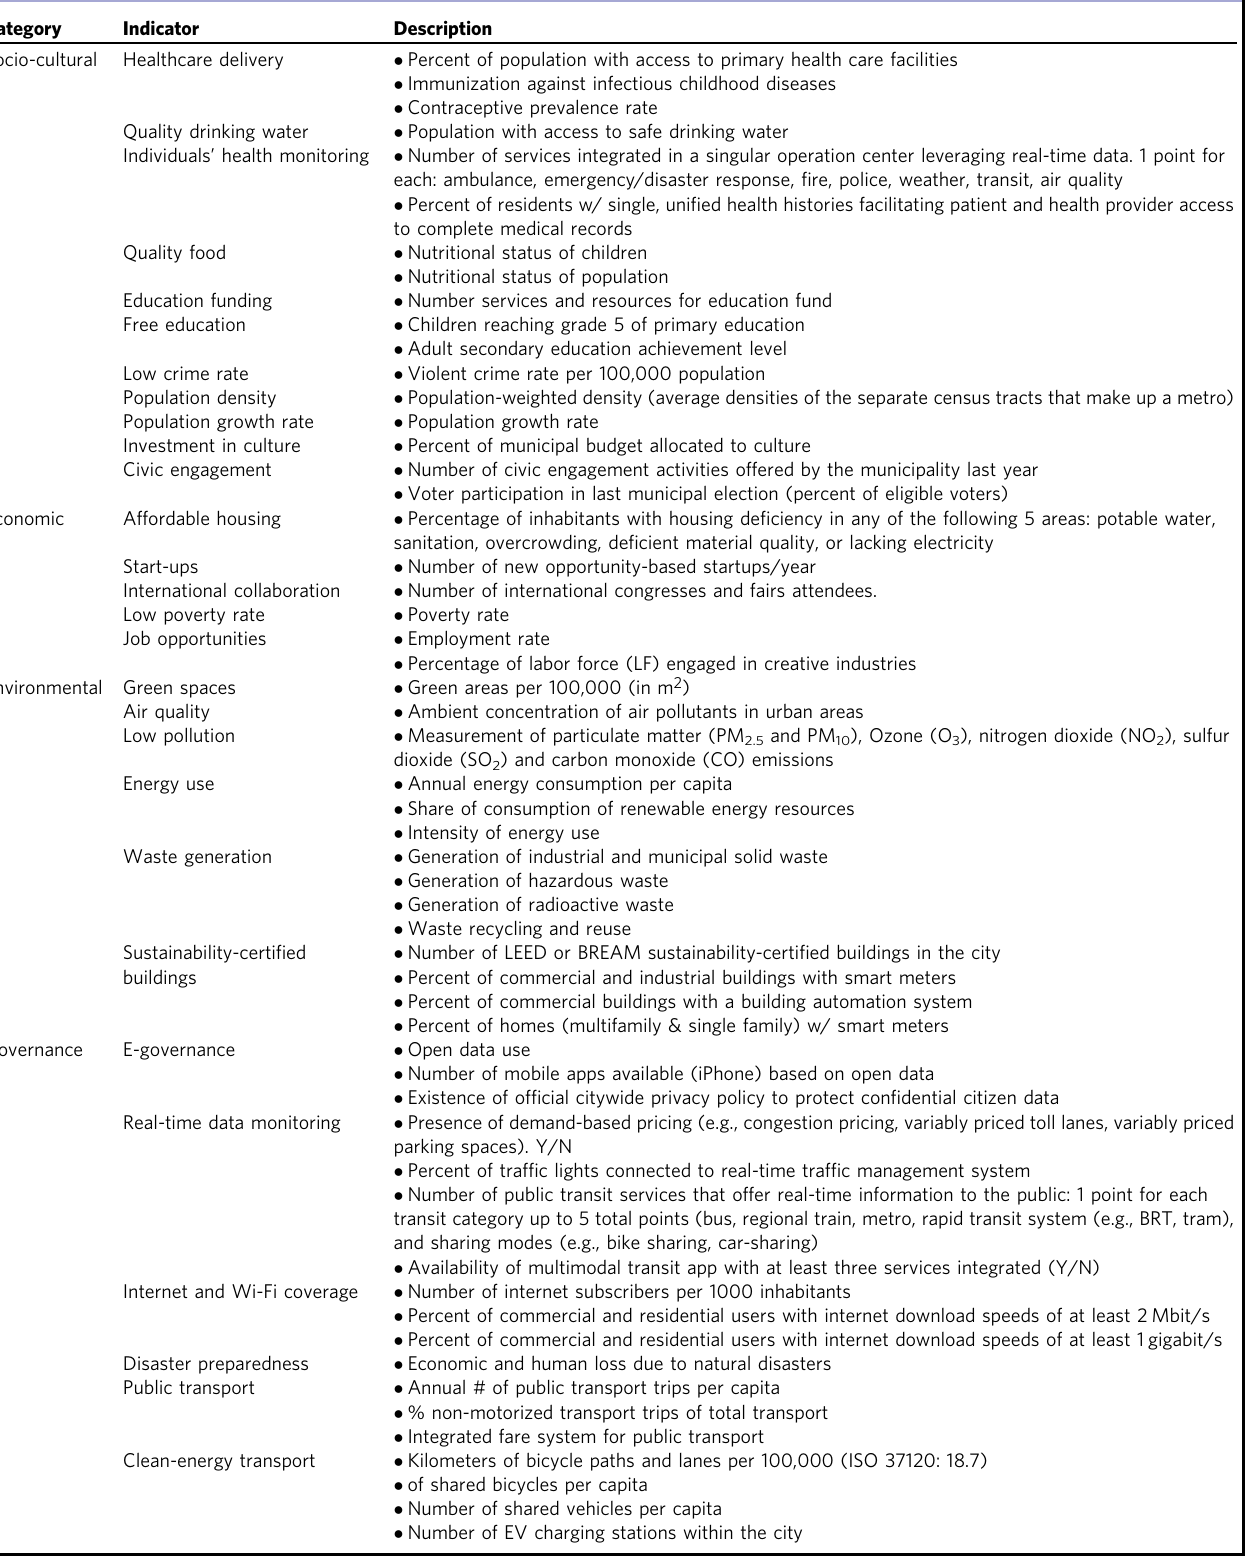
Table 3 Smart sustainable city